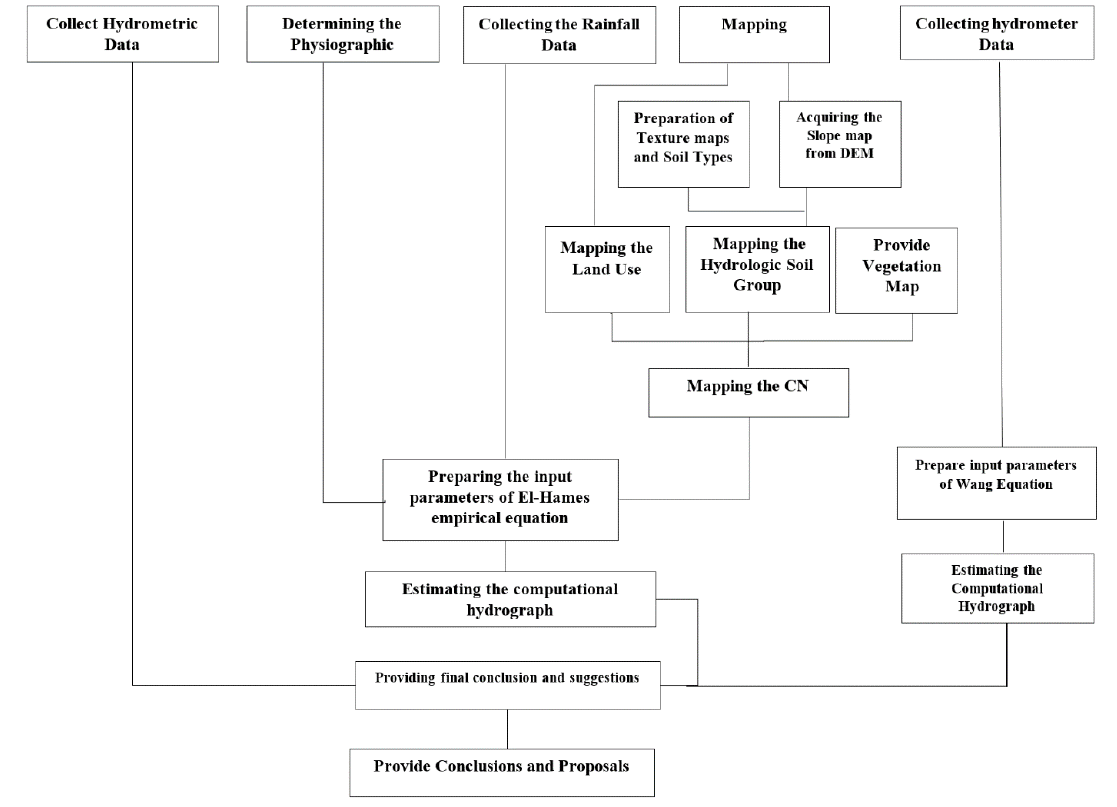
Figure 1. Flowchart of the research methodology Study